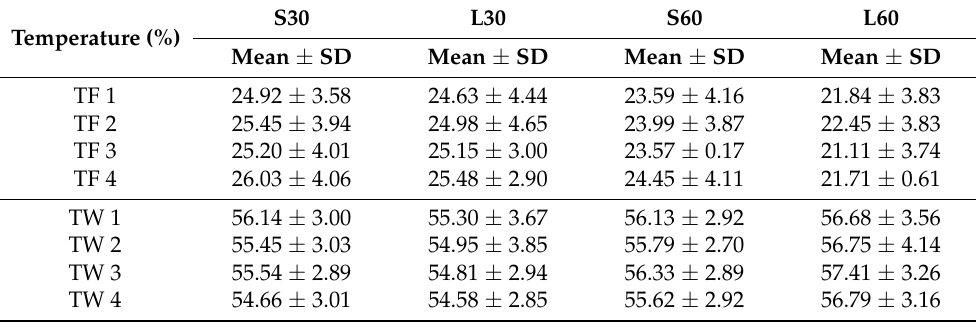
Figure 3. Exemplary thermograms taken before (on the left ) and 10 min after a vibrotherapy session (on the right ). Vibration therapy significantly reduced ellulite grade. In 51% of participants who exhibited grade 2 cellulite before the therapy, it decreased to grade 1. Accordingly, among those with grade 1 cellulite in the initial examination, it decreased to grade 0 in 54.5% of cases (Table 6). Table 4. Estimated total body fat and total body water percentages recorded during consecutive measurements during vibration